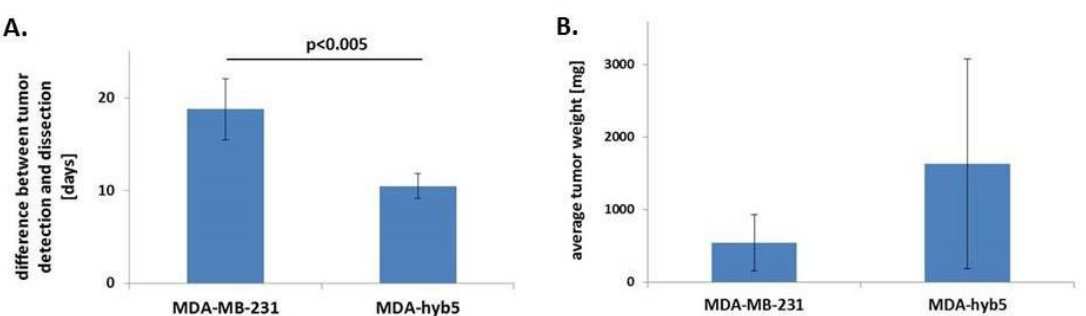
Figure 3. ( A ) The average time between the earliest detection of tumors and following dissection after growth of the tumors was calculated and compared between parental MDA-MB-231 cells ( n = 5) and fusion hybrid MDA-hyb5 cells ( n = 4). Significance ( p ) was calculated by unpaired student’s t -test. ( B ) The average tumor weight of MDA-MB-231- and MDA-hyb5-induced tumors was calculated by the mean ± s.d., respectively. Differences were not significant.